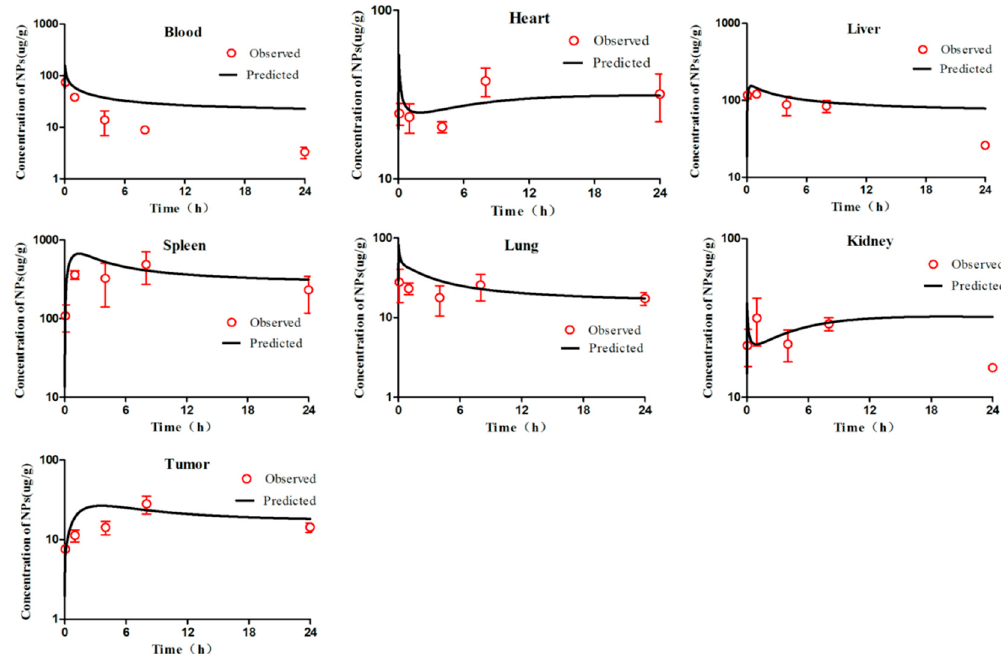
Figure 5. Simulated and experimentally measured concentration–time curves of mPEG5k-28.57%-200 nm NPs in murine blood and tissues after intravenous injection.